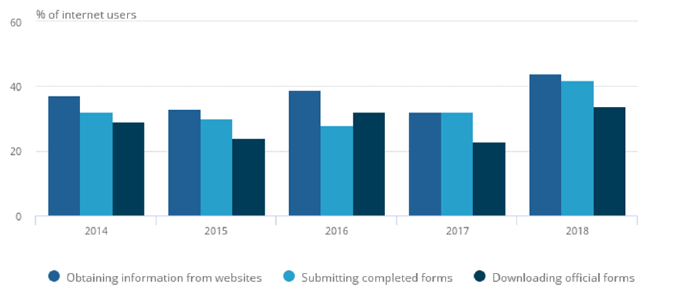
Figure 1: A survey on the percentage of internet users by type of interaction demonstrated that the internet is increasingly being used to interact with public authorities or services (Office for National Statistics 2018)